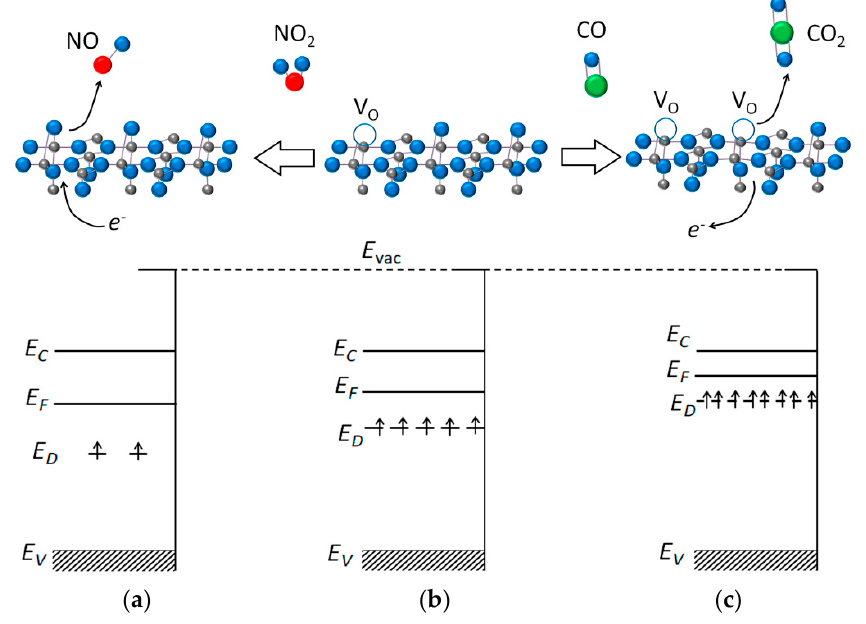
Figure 3. Schematic representation of the n -type MOS with oxygen vacancies and lattice oxygen anions ( b ), and after its interaction with reducing gas CO ( c ) and oxidizing gas NO 2 ( a ) within the oxygen vacancy model of sensor response ( top ); and the assumed changes in donor states population ( E D ) and Fermi level positions ( E F ) ( bottom ).